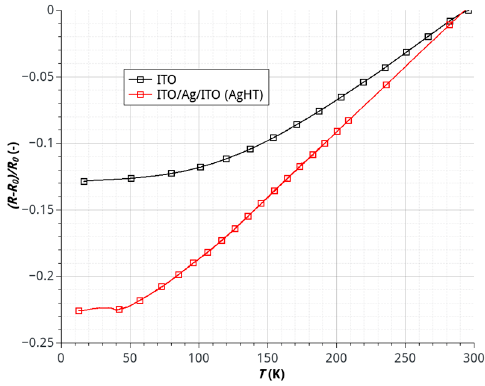
Figure 2. Temperature dependence of resistance of electrodes prepared from conductive polymers.